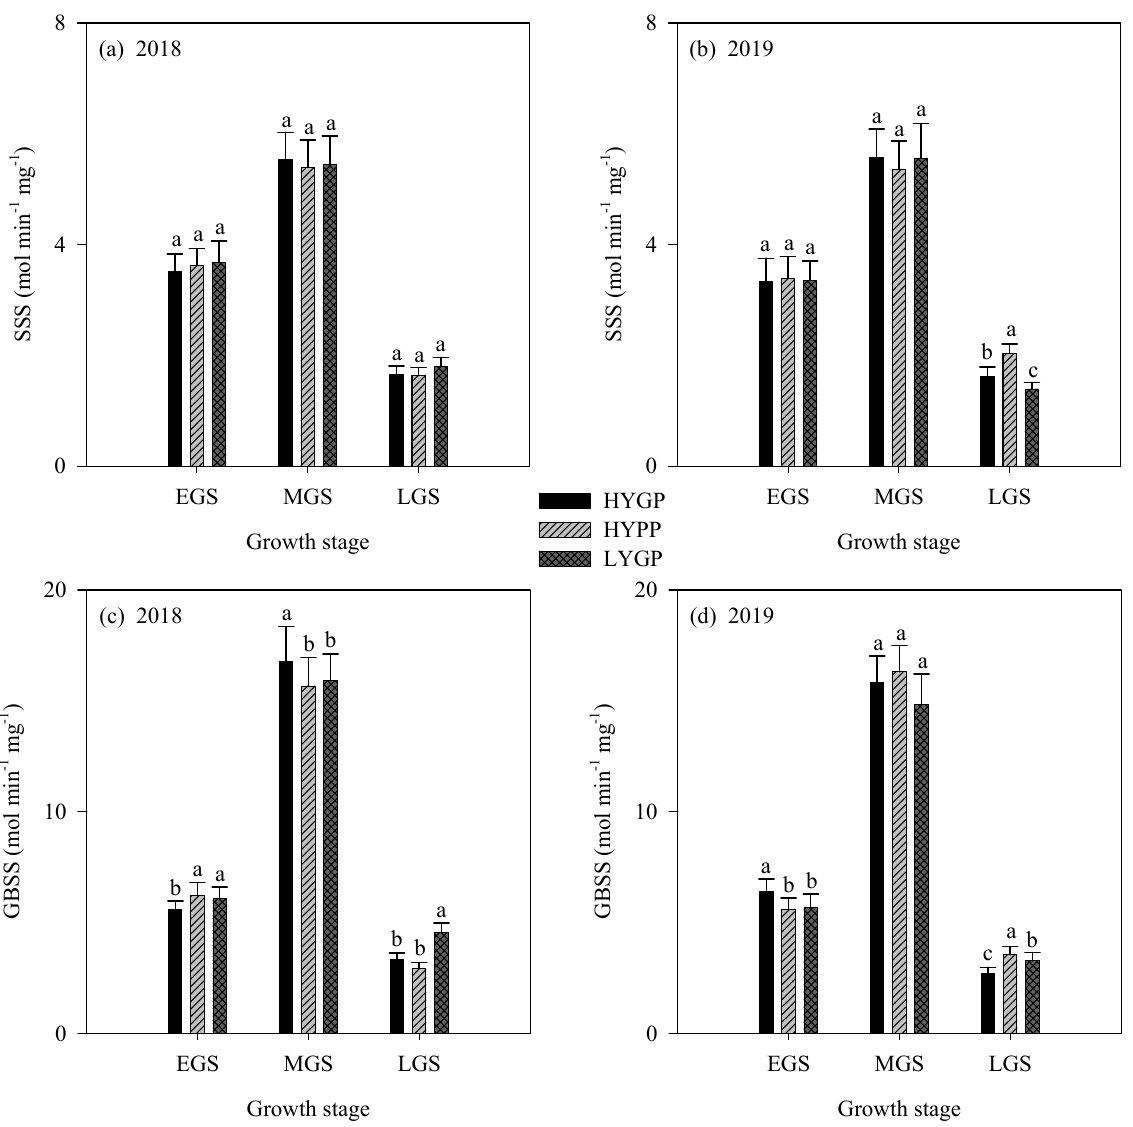
Figure 5. SSS ( a , b ) and GBSS ( c , d ) activities in grains after the heading of rice cultivar types. SSS, soluble starch synthase; GBSS, granule bound starch synthetase; HYGP, high-yielding rice with good palatability; HYPP, high-yielding rice with poor palatability; LYGP, low-yielding rice with good palatability; EGS, early grain-filling stage; MGS, middle grain-filling stage; LGS, late grain-filling stage. Different lowercase letters in the same growth stage above the histogram indicate statistical significance at the p < 0.05 level.